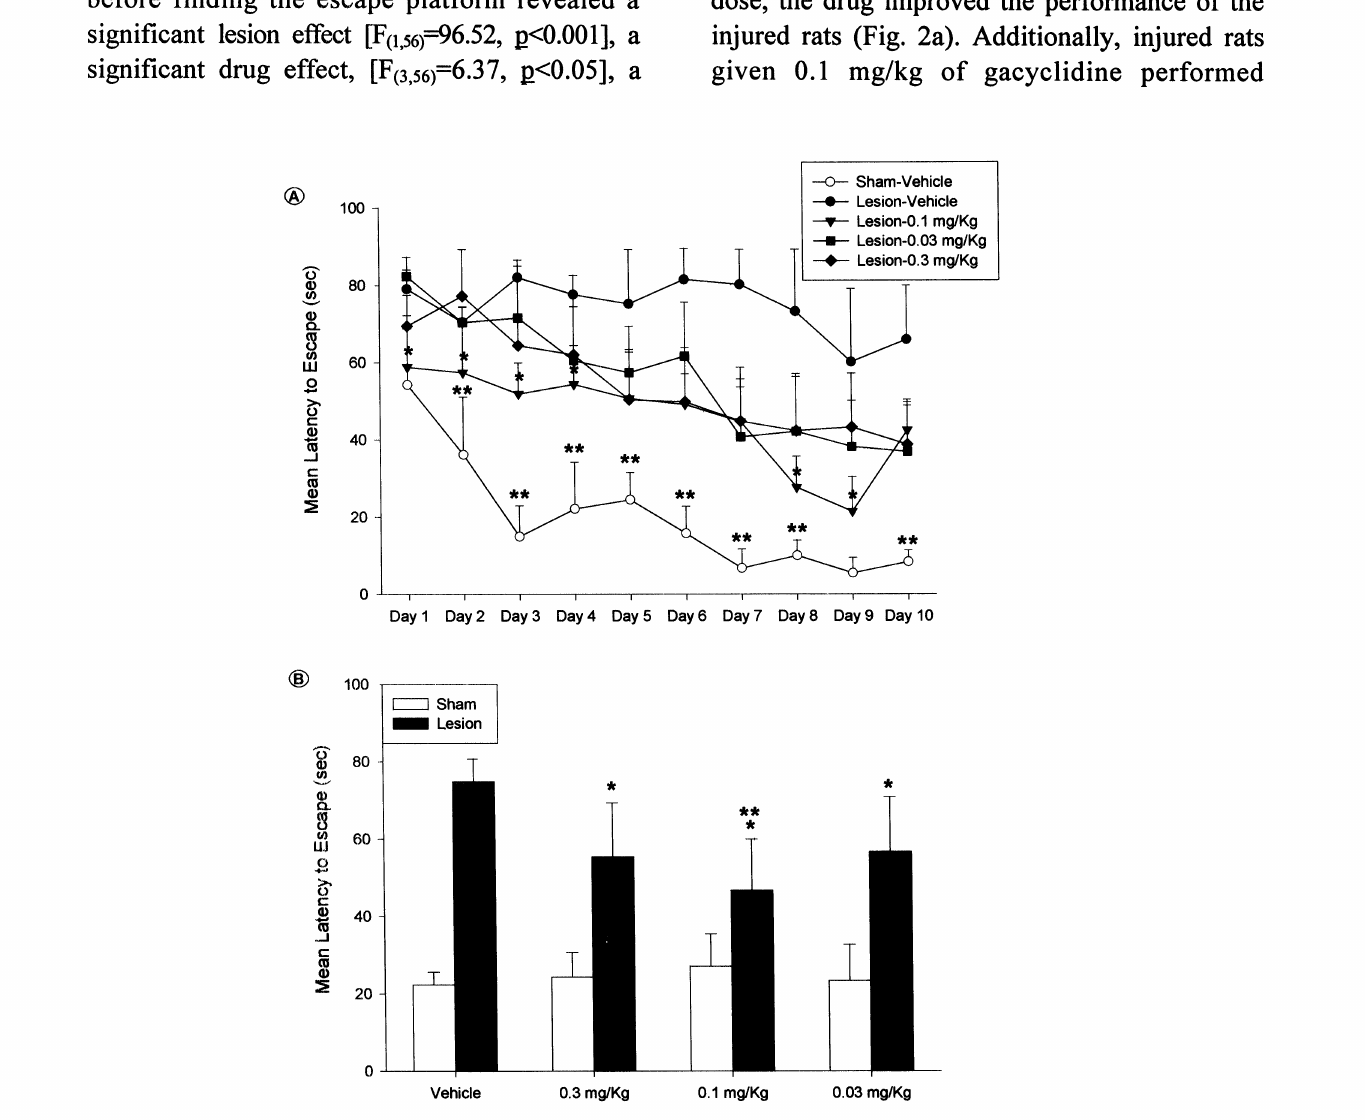
Fig. 2: (a) Measures of swim time in the water tank before finding the escape platform show that rats given 0.1 mg/kg of gacyclidine performed better than the other treatment groups, both early and late in training (*=p<0.05). Regardless of dose, intact rats performed significantly better than any of the three gacyclidine groups (**=p<0.05), except on day 8, when the 0.1 mg/kg group was not significantly different from the intact controls. (b) Collapsing the data across days revealed that injured rots receiving 0.1 mg/kg performed better than those receiving either of the other two doses (**=p<0.05). All injured rats receiving gacyclidine, regardless of dose, performed better than their untreated counterparts (*=p<0.05). (Error bars represent